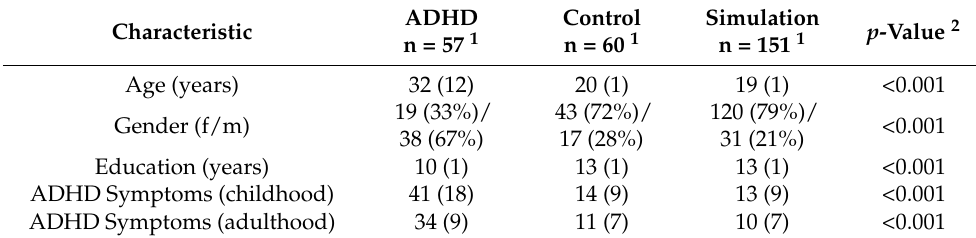
Table 1. Demographic